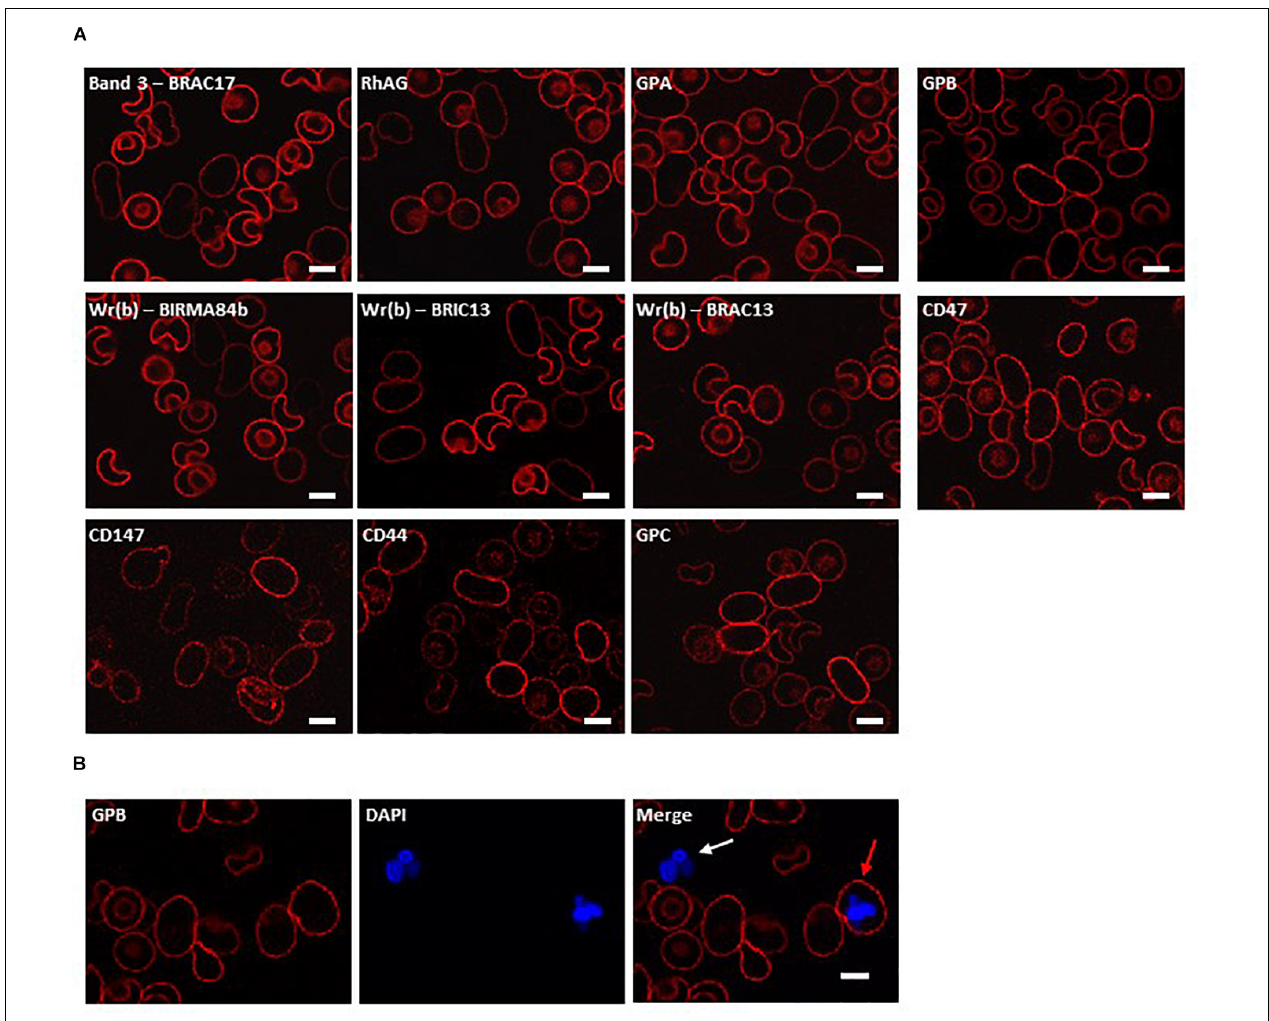
FIGURE 1 | Immunocytochemistry of homozygous SAO erythrocytes. Circulating erythrocytes from the homozygous SAO individual, containing both large, aberrantly-shaped homozygous SAO cells and normal biconcave donor cells, were imaged using immunofluorescent labeling and confocal microscopy. (A) Red cells were reacted with monoclonal antibodies directed to extracellular epitopes of membrane proteins of interest: Band 3 (BRAC17), RhAG (LA1818), GPA (BRIC256), GPB (and to a lesser extent GPA) (R1.3), Wr(b) (BIRMA 84b, BRIC13 and BRAC13), CD47 (BRIC211), CD147 (MEM6-6), CD44 (BRIC235), and GPC (BRIC10). (B) Red cells were co-stained with erythroid marker anti-GPB (and to a lesser extent GPA, R1.3; red) and DNA dye DAPI (blue). The white arrow indicates a leukocyte, the red arrow indicates an erythroid cell that has retained nuclear material. Numbers of nucleated erythroid cells were not sufficient to quantify accurately but were seen occasionally in the confocal slides of homozygous SAO peripheral blood whereas they are very rare in control slides. Images are representative of at least 5 different fields from one experiment. Scale bars represent 5 µ